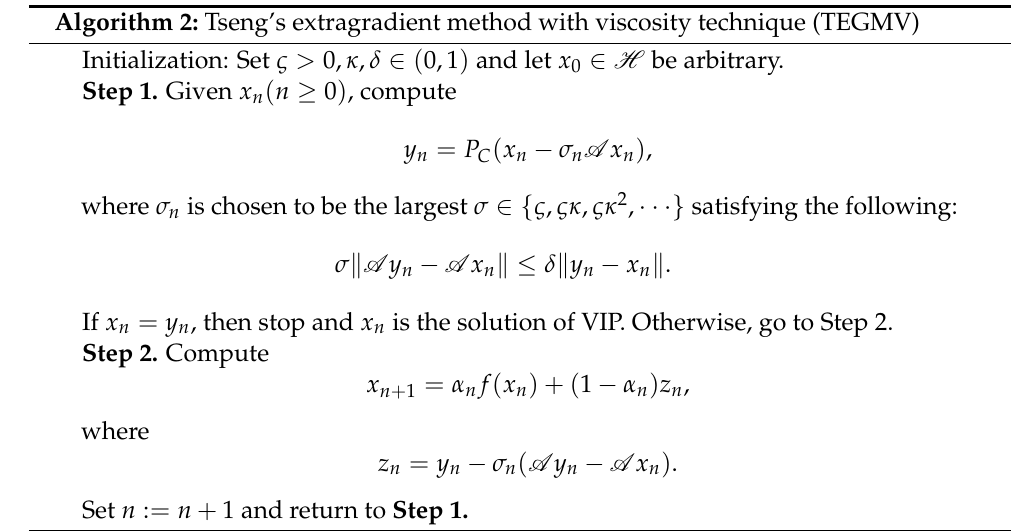
Algorithm 2: Tseng’s extragradient method with viscosity technique